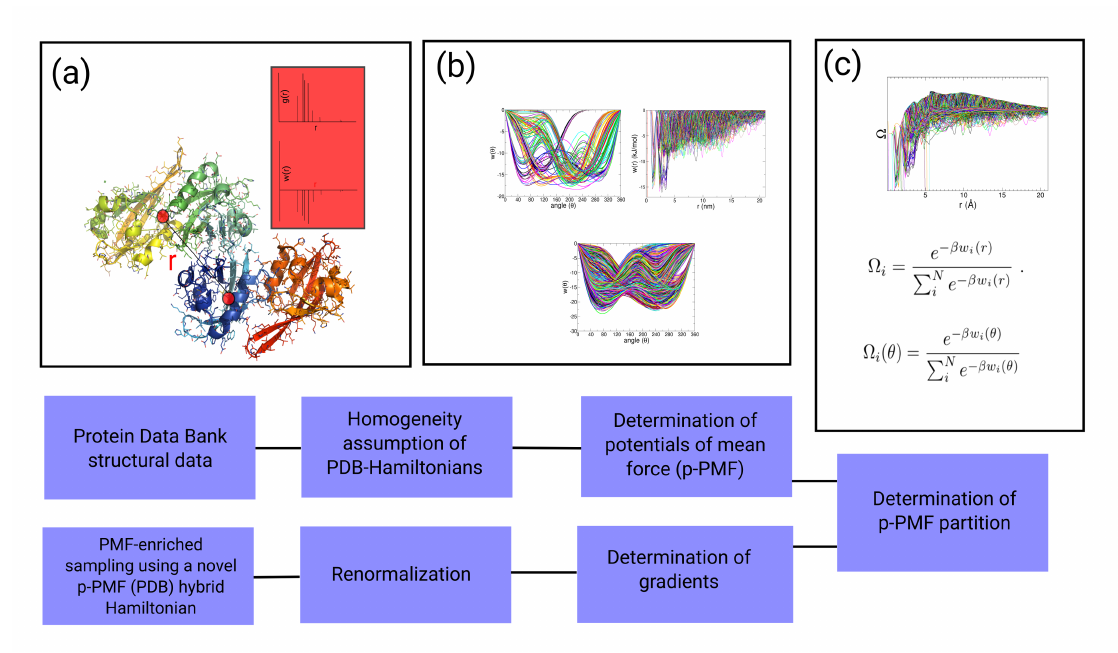
Figure 1. The potential of mean force (PMF)-enriched sampling technique involves a number of technical and theoretical steps for the application of pseudo -potentials of mean force (p-PMFs) in the enhanced sampling of proteins and DNA. ( a ) Scheme for the determination of pair correlations g ( r ij ) and correlation functions in the torsion space g ( θ k ) ; ( b ) p-PMFs in the radial and the torsion space generated from the PDB data; ( c ) Partition function Ω ( r ij ) used in the propagation of the system. The gradient of the partition function along r ij is used for the propagation of the system. In the panel below, we show the different technical, algorithmic, and theoretical steps for the generation of the PDB-derived hybrid Hamiltonian for the enhanced sampling of proteins and